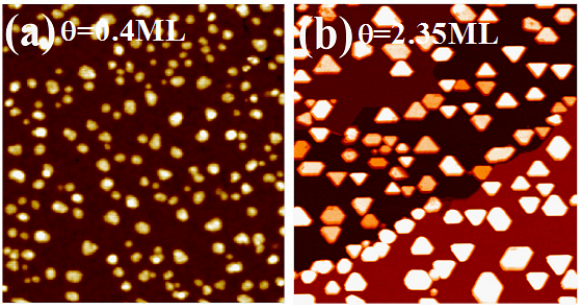
Figure 3. ( a ) The nucleated island density after 0.4 ML of Dy has been deposited at room temperature over an area of 1000 × 1000 Å 2 . The island density is 2 × 10 − 4 islands/Å 2 indicating slow diffusion; ( b ) Dy (2.35 ML) deposited on graphene with a flux rate 0.23 ML/min at 660 K. The area size is 2500 × 2500 Å 2 . These islands have height difference multiples of 0.28 nm, the Dy step